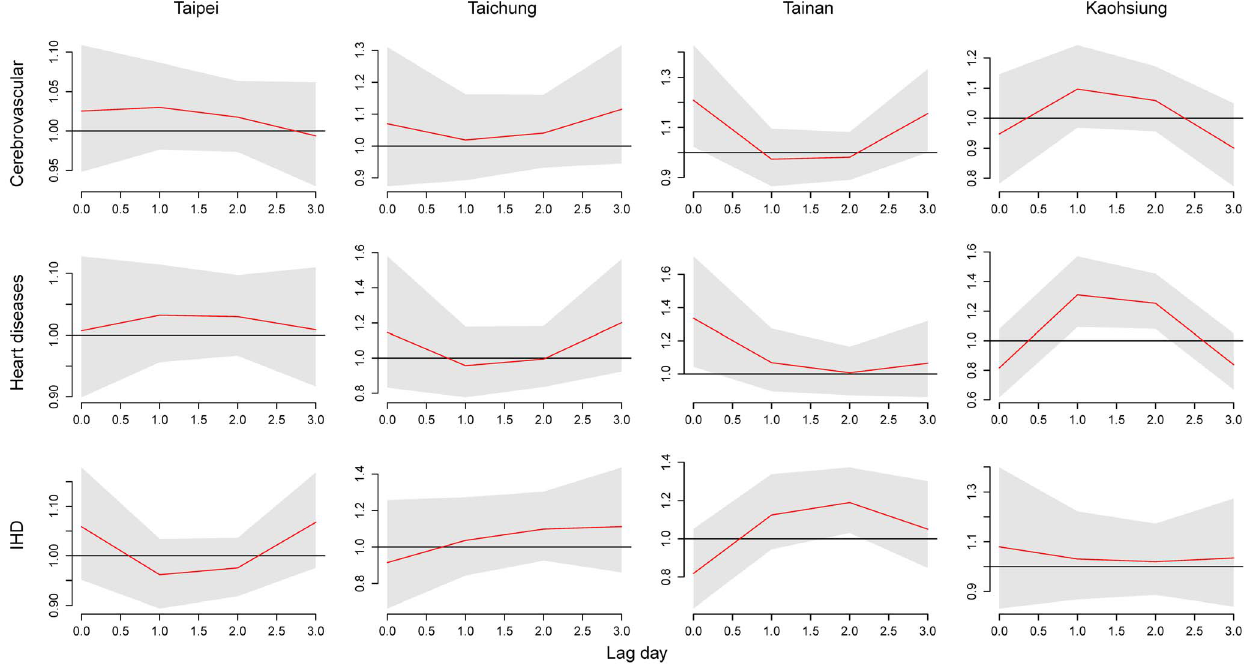
Figure 4. Mortality risks for cerebrovascular diseases, heart diseases, and IHD associated with an ambient temperature of 31 6 C compared to a centered temperature of 27 6 C on lag 0 to 3 in metropolitans Taipei, Taichung, Tainan, and Kaohsiung during 1994– 2007.